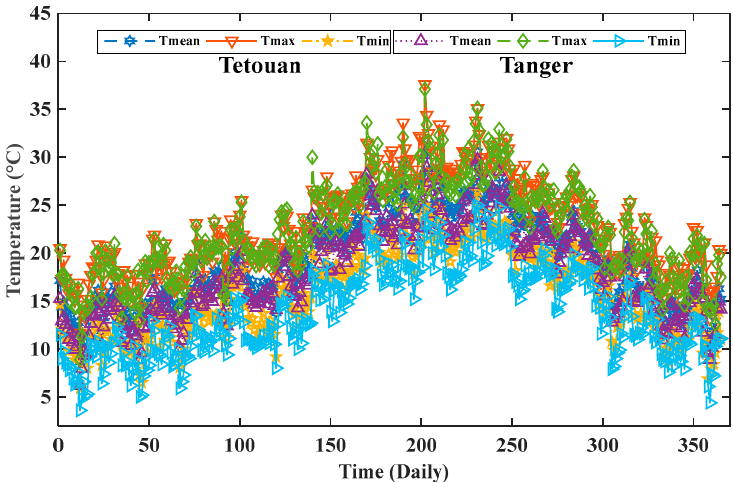
Figure 2. Mean, maximum, and minimum daily temperature of Tetouan and Tangier sites.